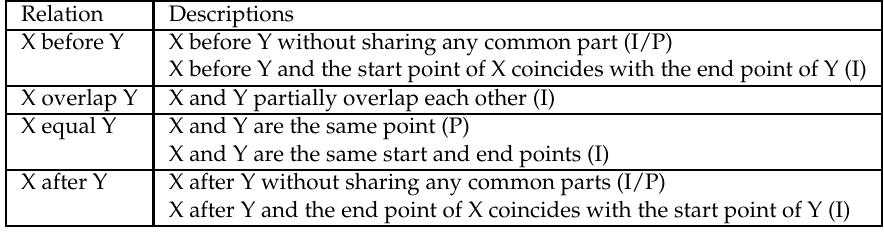
Table 3: Definitions of linear order